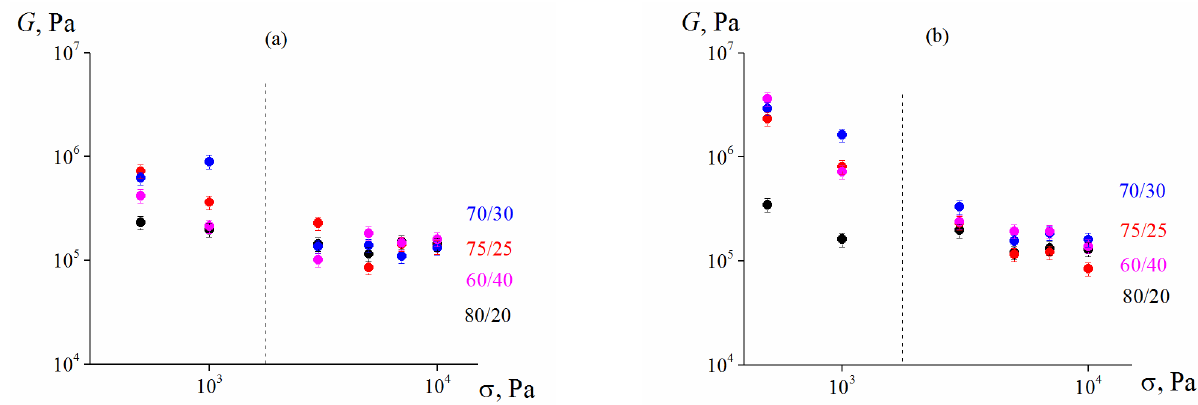
Figure 7. Development of strain and recovery at the applying constant shear stress and its relaxation for the 80 vol.% suspension ( λ = 2.4) with a 20% content of smaller particles. Stresses are shown in the Figure.